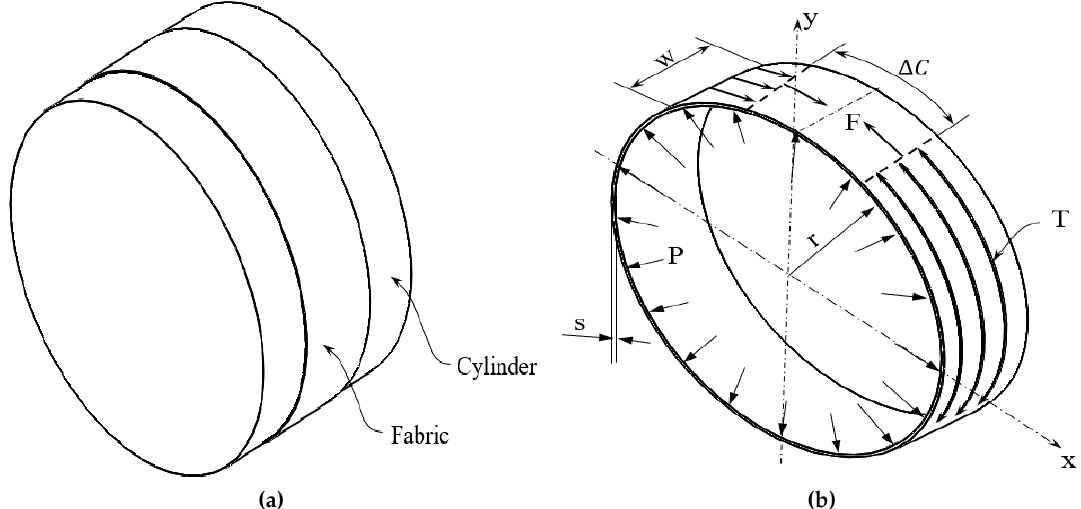
Figure 6. ( a ) PVC cylinder and fabric interface. ( b ) Forces present: pressure (P) and tension (T) for a cylinder with radius (r).